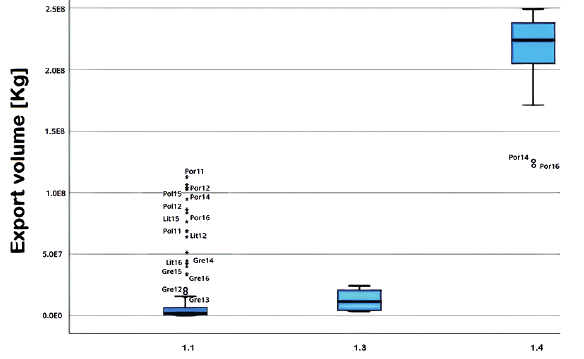
Figure 14. Post-crisis box diagram of export variable according to the clusters of the second two-stage clustering level (source: own